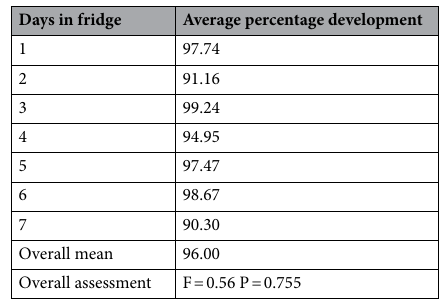
Table 1. Negative control showing the percentage of eggs that developed Nezara viridula nymphs after egg masses were kept at 10 °C for up to a week (N = 3 egg masses per day spent in refrigerator; 21 egg masses in total).